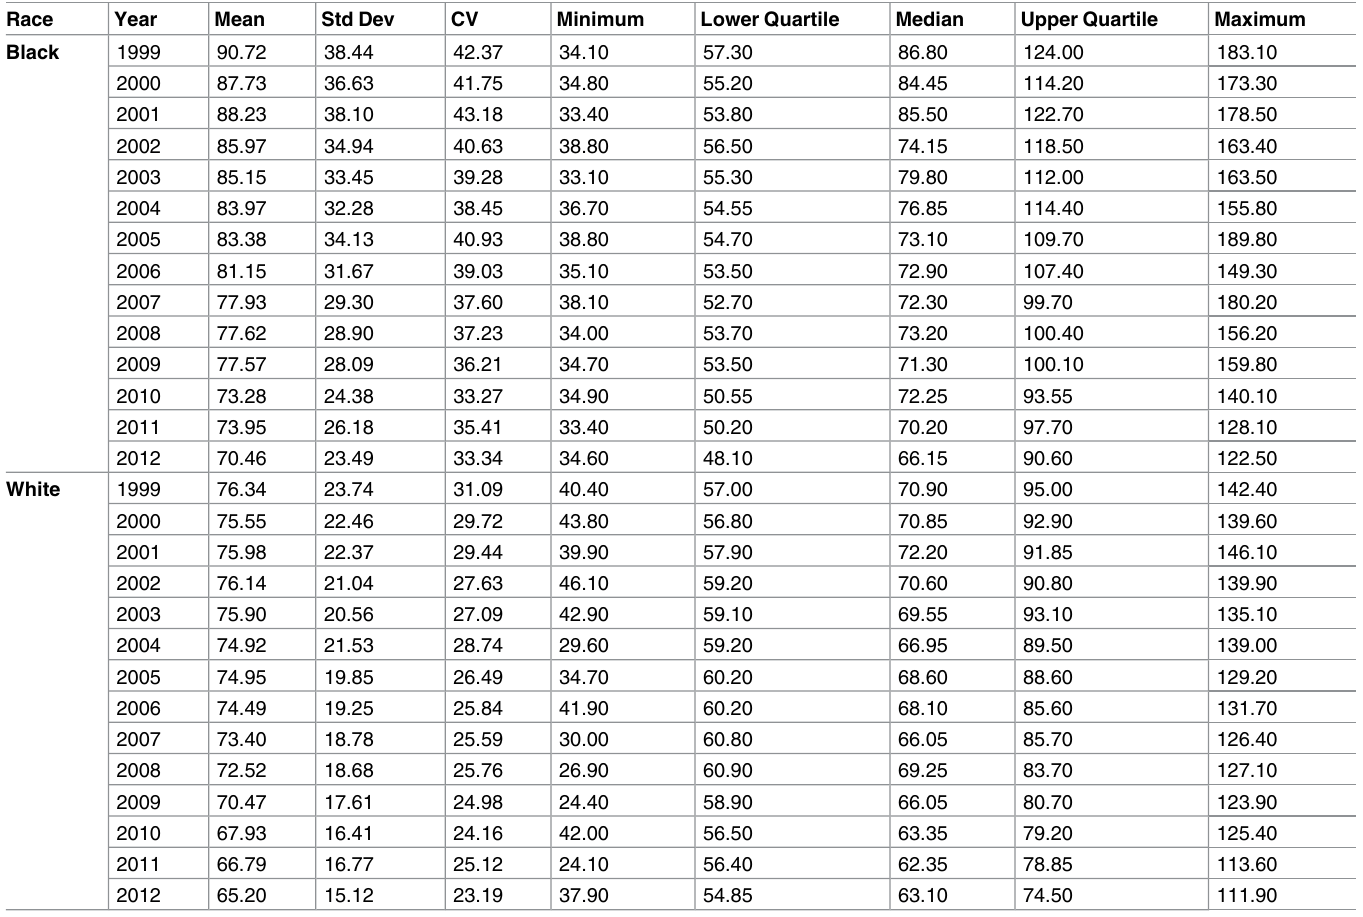
Table 2. Lung cancer incidence rates by race, 1999–2012 (cases per